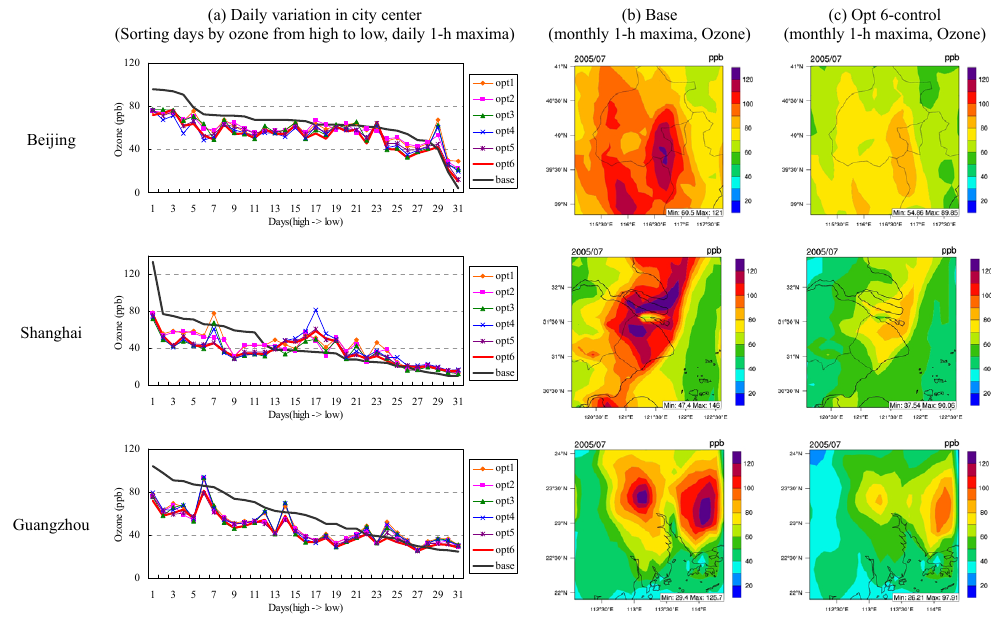
Fig. 13 Effectiveness of NO x /VOC control strategies to achieve secondary national ozone standards in 3 cities